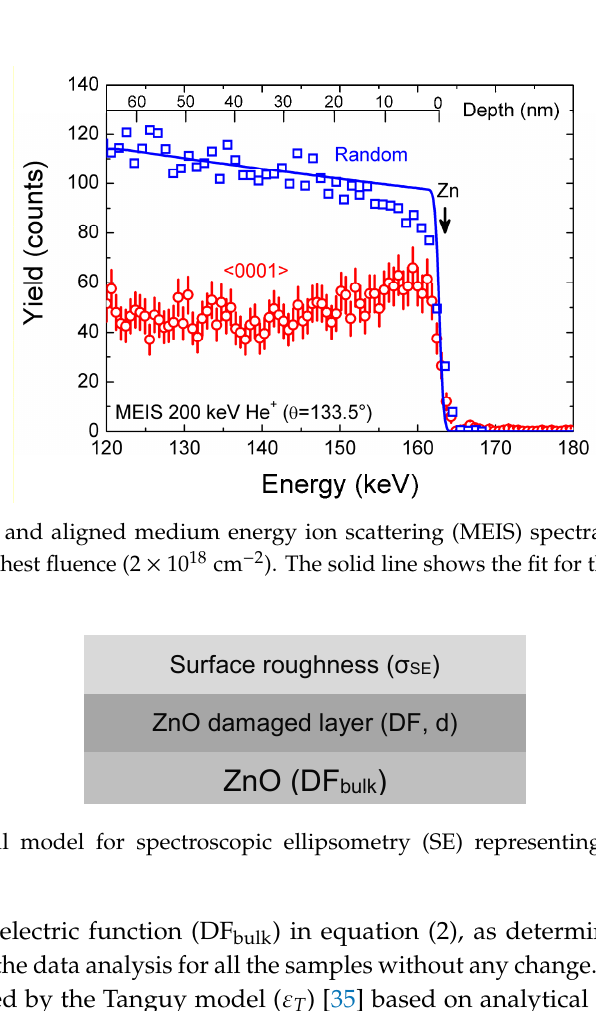
Figure 4. Random and aligned medium energy ion scattering (MEIS) spectra of the ZnO sample irradiated at the highest fluence (2·10 18 cm −2 ). The solid line shows the fit for the random spectrum.